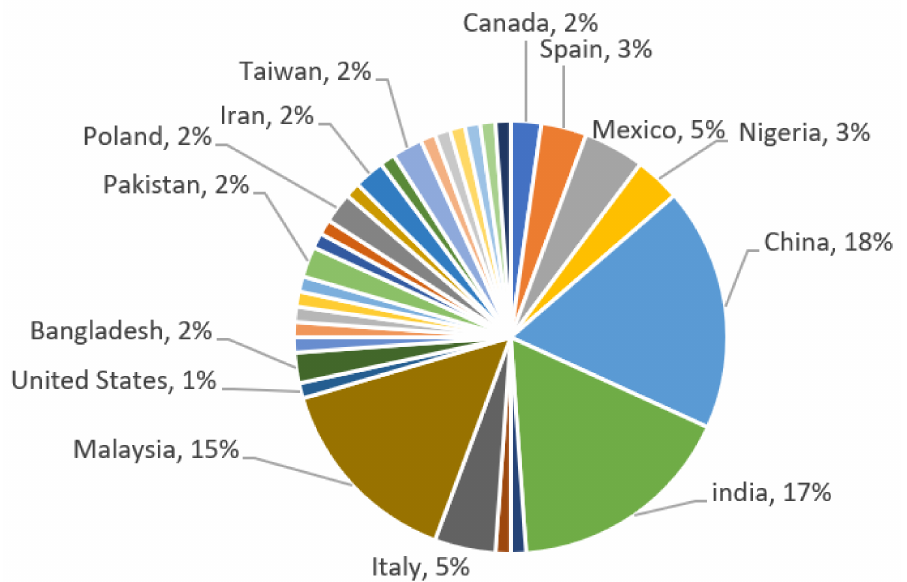
Figure 4. Percentage of research studies conducted by country of